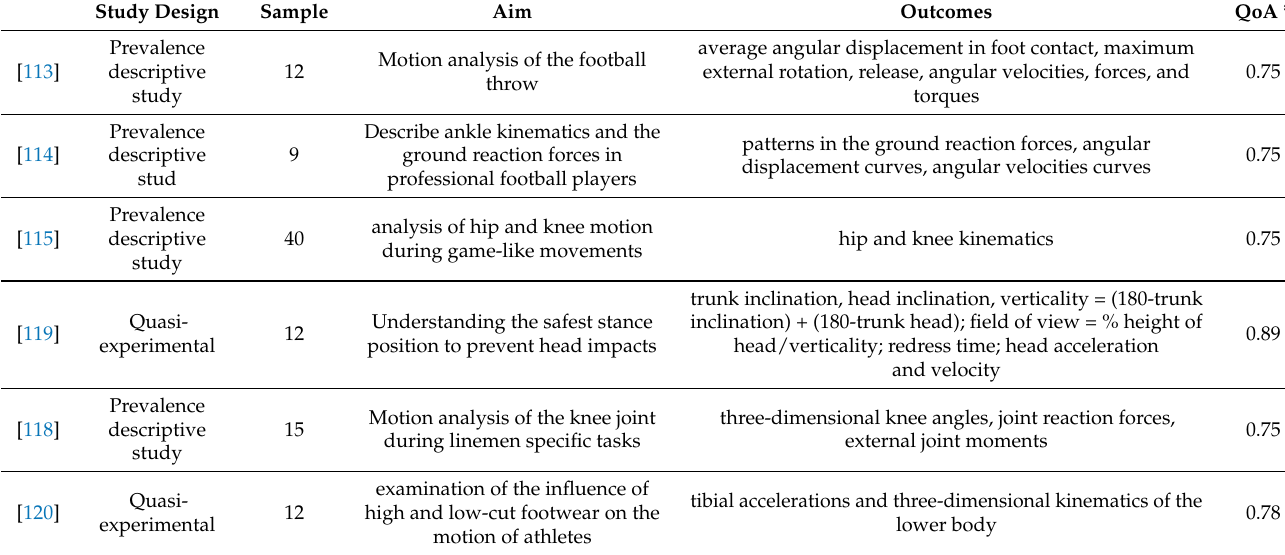
Table 7. Studies regarding the biomechanics of